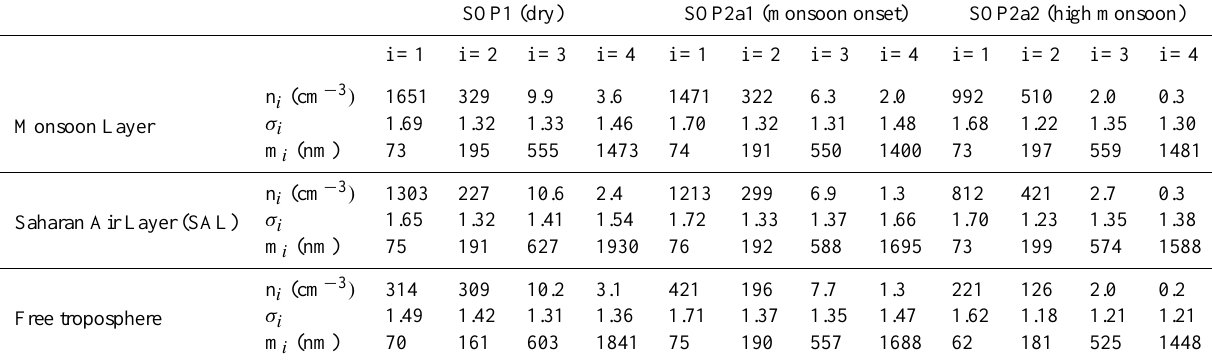
Table 1. Parameters (number concentration (n i ) , geometric standard deviation ( σ i ) , and number median particle diameter (m i ) ) for the mean particle size distributions shown in Fig. 4, expressed as the sum of four log-normal modes.